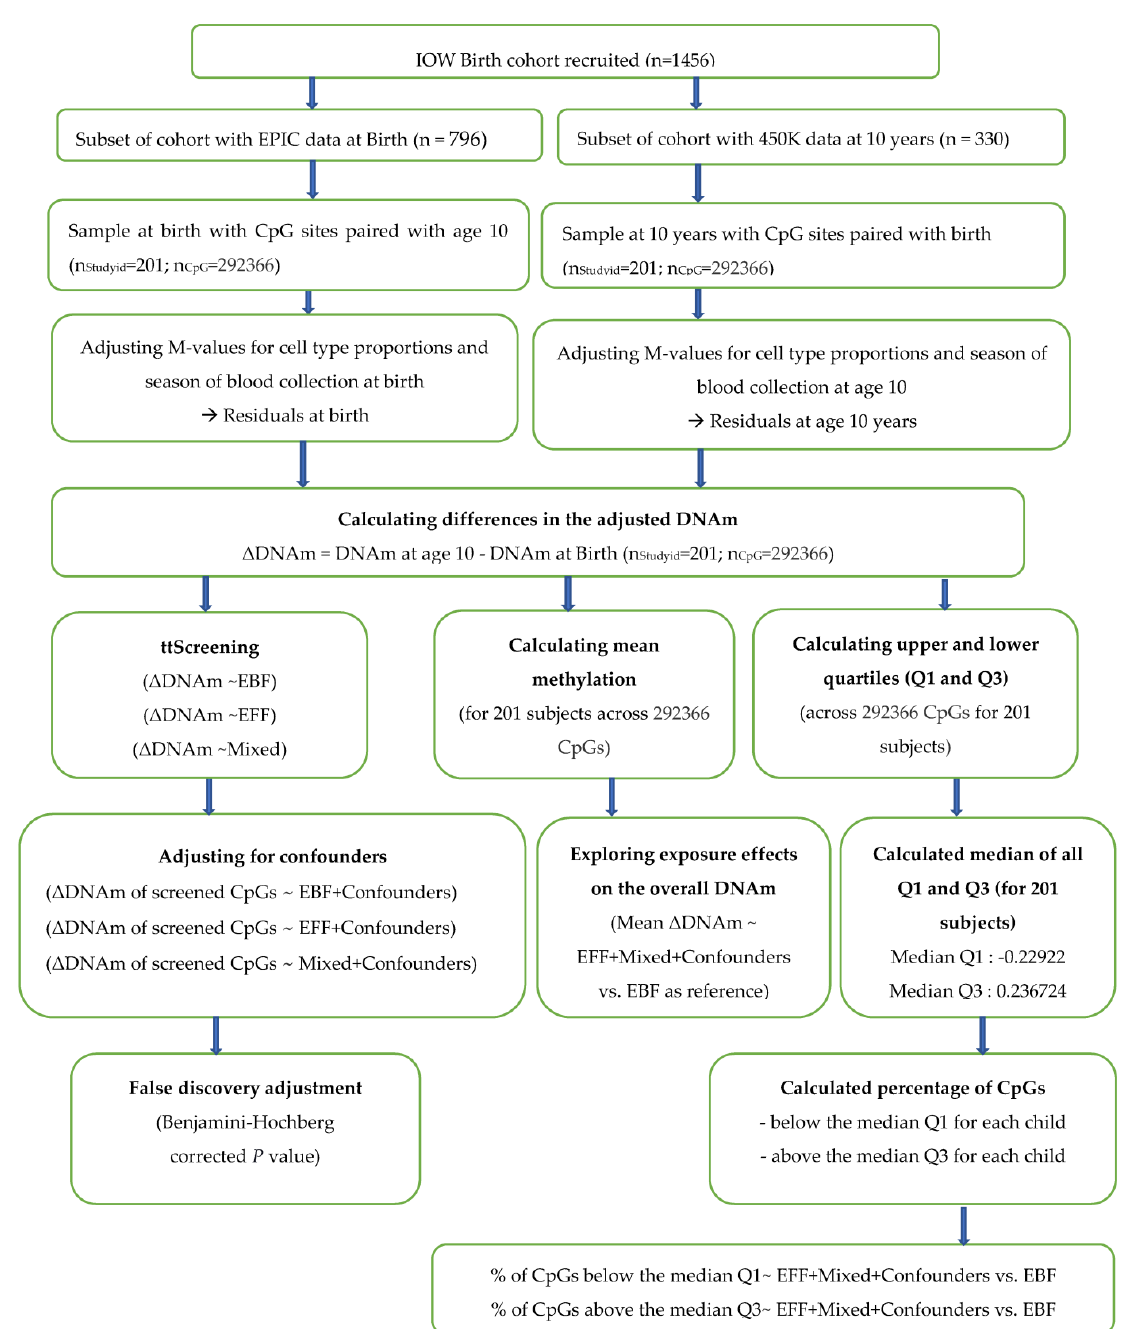
Figure 1. Flow chart of statistical analyses. nStudyid and nCpG represent the number of study participants and CpGs considered in the analysis, DNAm (DNA methylation), and Residual-DNA methylation after taking out the effects of cell-type proportions and season of blood collection at both time points. ttScreening—training and testing screening method, EBF—exclusively breastfed for at least 13 weeks, EFF—exclusively formula fed for at least 13 weeks, Mixed—a mixture of breastmilk with formula or solids before 13 weeks, ΔDNAm M-values—delta DNA methylation (calculated using M- values) that represents change in DNA methylation from birth to 10 years after adjusting for the cell-type proportions and season of blood collections at both time points.